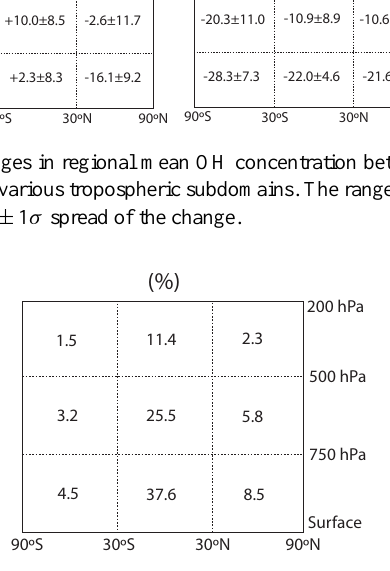
Fig. 8. The percentage of global methane that is oxidised in various subdomains of the atmosphere in present day (year